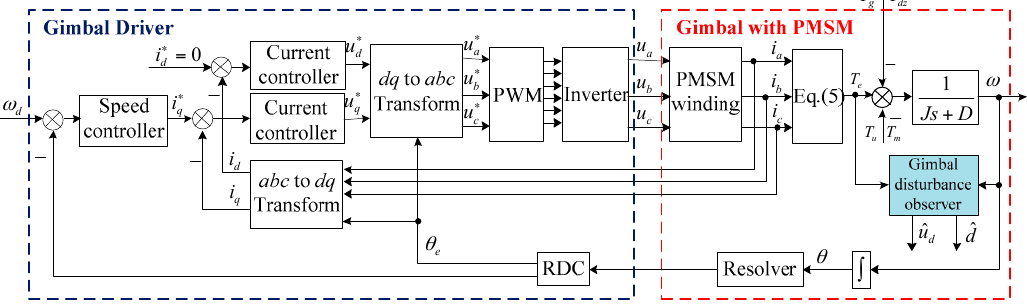
Figure 6. Block diagram of disturbance observer and gimbal servo system.